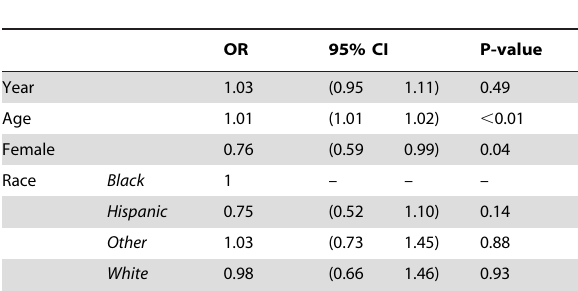
Table 3. Association of various demographic variables and likelihood of a positive CTPA scan.